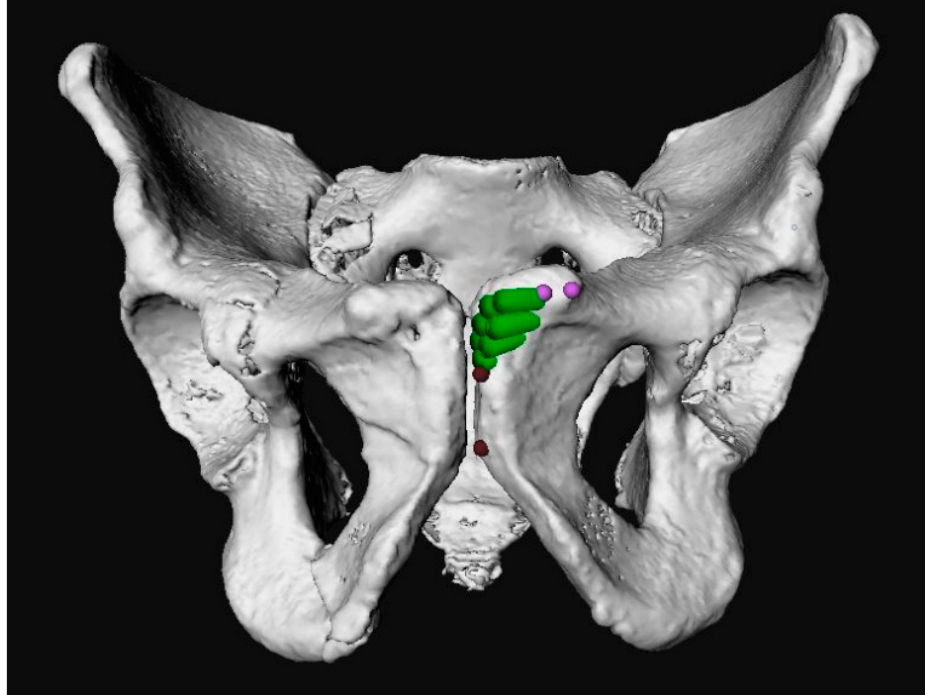
Figure 6. Measurement of the distance between the upper limit of the entry points (green) and the pubic tubercle was measured (pink), and the distance from the lower limit of the entry points (green) to the ramus inferior border (red). Table 2. Entry zone analysis.